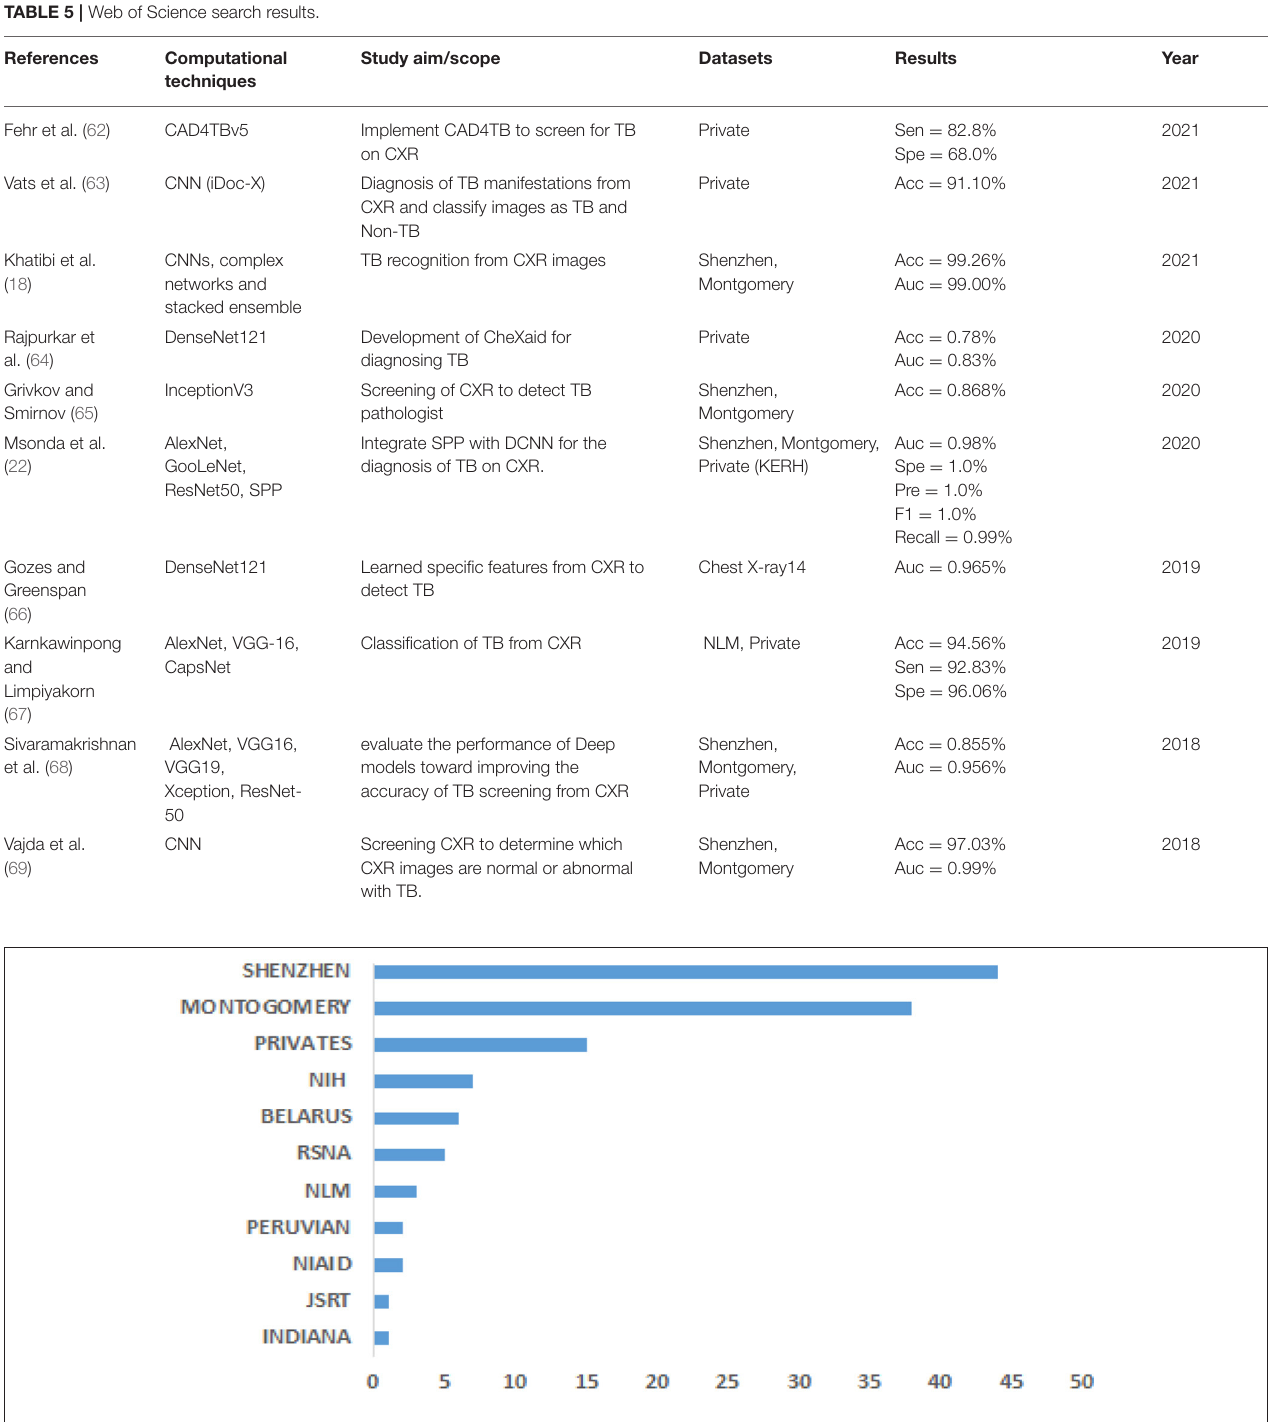
FIGURE 3 | Dataset frequency of